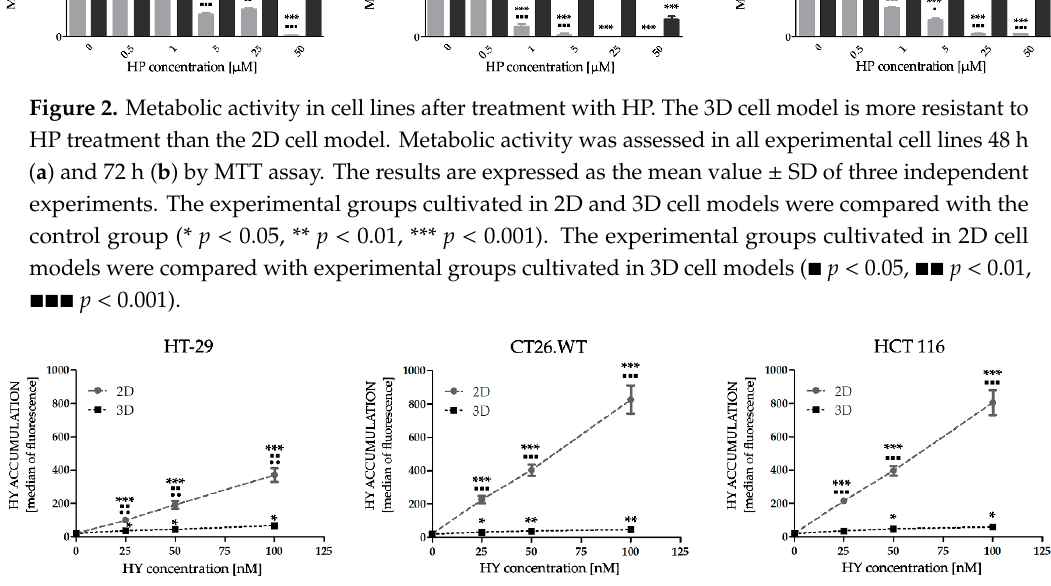
Figure 2. Metabolic activity in cell lines after treatment with HP. The 3D cell model is more resistant to HP treatment than the 2D cell model. Metabolic activity was assessed in all experimental cell lines 48 h ( a ) and 72 h ( b ) by MTT assay. The results are expressed as the mean value ± SD of three independent experiments. The experimental groups cultivated in 2D and 3D cell models were compared with the control group (* p < 0.05, ** p < 0.01, *** p < 0.001). The experimental groups cultivated in 2D cell models were compared with experimental groups cultivated in 3D cell models ( ▪ p < 0.05, ▪▪ p < 0.01, ▪▪▪ p < 0.001).